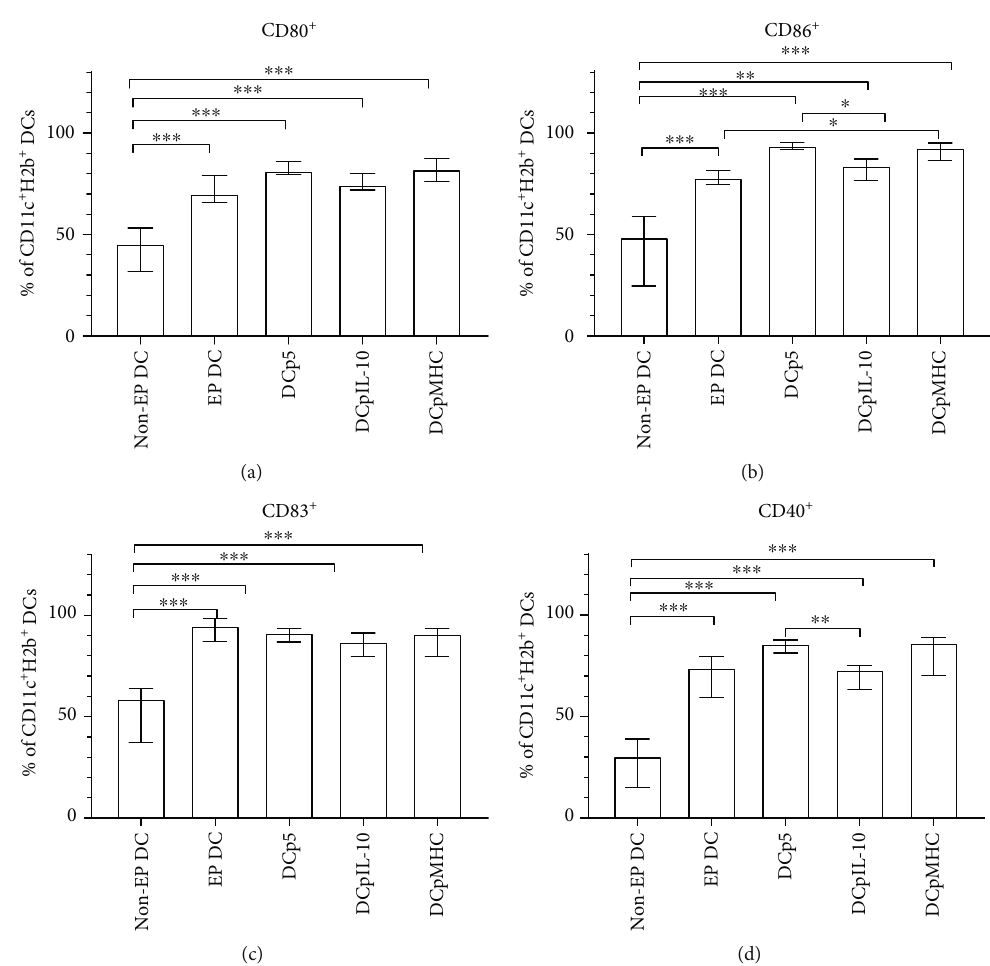
Figure 2: Relative quantities of cells expressing surface markers (a) CD80 + , (b) CD86 + , (c) CD83 + , and (d) CD40 + among groups of electroporated and nonelectroporated DCs. N = 12 per group. Data are presented as median and interquartile range. Brackets indicate signi fi cant di ff erences (Kruskal-Wallis test with Dunn ’ s corrected multiple comparisons, ∗ P < 0 : 05 , ∗∗ P < 0 : 01 , ∗∗∗ P < 0 : 001 ). Non-EP DC: nonelectroporated DCs; EP DC: DCs electroporated without a plasmid; DCp5: DCs electroporated with a control plasmid encoding antigenic determinants from the H2 locus of CBA mice, which do not di ff er from the homologous antigenic determinants of C57BL/6 mice; DCpIL-10: DCs electroporated with a plasmid encoding mouse IL-10; DCpMHC: DCs electroporated with a plasmid encoding antigenic determinants from the H2 locus of CBA mice, which di ff er from the homologous antigenic determinants of C57BL/6